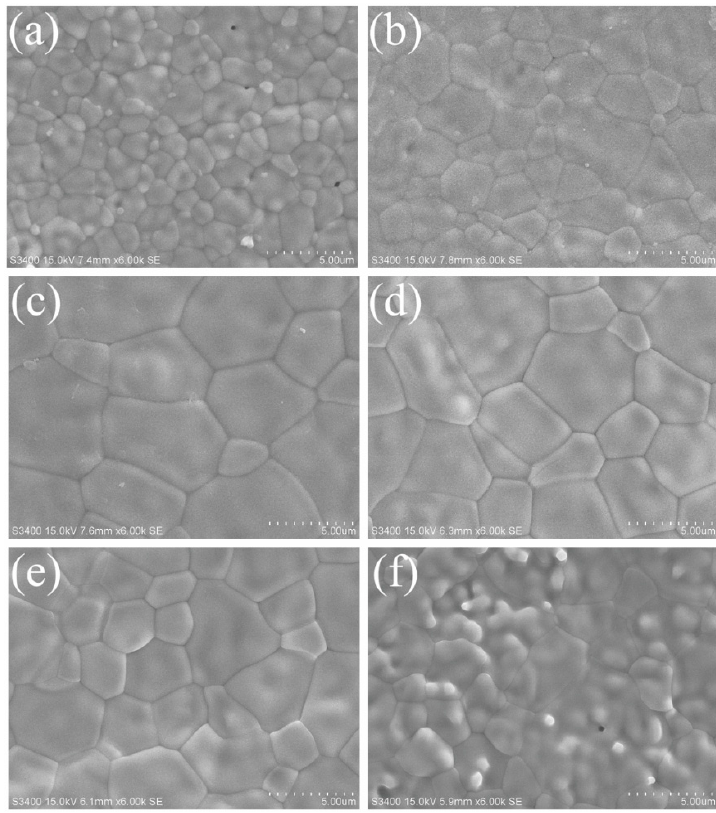
Figure 2. Scanning electron microscope (SEM) images of sintered Sc 0 . 1 Ce 0 . 05 Gd 0 . 05 Zr 0 . 89 O 2 ( SCGZ ) at ( a )